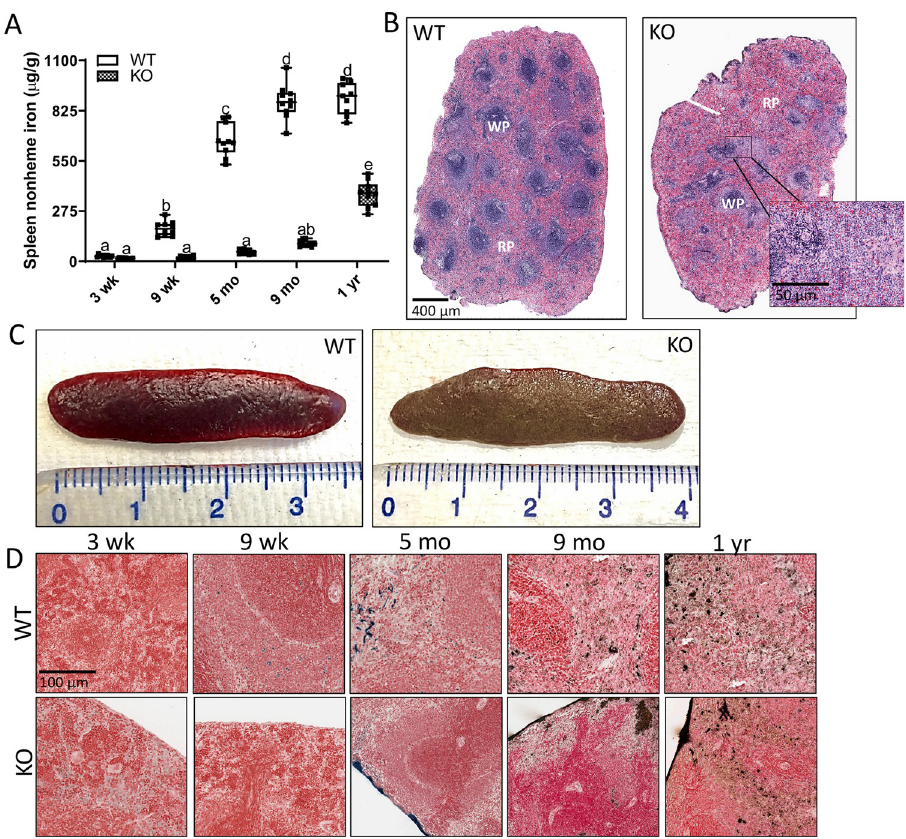
Fig 10. Splenic iron is depleted in male Hamp -/- rats. Nonheme iron levels were assessed in spleens of Hamp KO rats at various ages ( A ). Data are presented as box plots for n = 8–10 rats/group. Data were log transformed before being analyzed by 2-way ANOVA followed by Tukey’s multiple comparisons test; however, untransformed data are presented for ease of interpretation. Groups without a common letter differ significantly ( p � 0.048). Genotype × Age, p < 0.0001; Age, Genotype p < 0.0001. Representative images of H&E staining of paraffin-embedded spleen sections from 10-month-old male WT and Hamp -/- rats are also depicted ( B ). In * 65% of older male KOs (i.e., > 9 months of age), the spleens had an abnormal appearance, and the relative red pulp (RP)/white pulp (WP) ratio was altered (compared to normal spleens from unaffected KOs and WT rats) ( C ) ( p < 0.05 by 1-way ANOVA) [n = 5/group]. The ruler indicates centimeters. Representative images of Cobalt DAB-enhanced Perls’ Prussian blue iron staining in paraffin-embedded spleen sections at different ages are also shown ( D